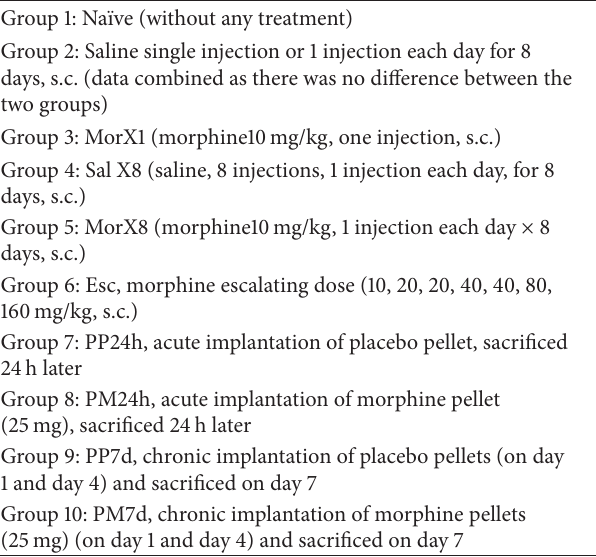
Table 1: Morphine treatment schedule. Group 1: Na¨ıve (without any treatment) Group 2: Saline single injection or 1 injection each day for